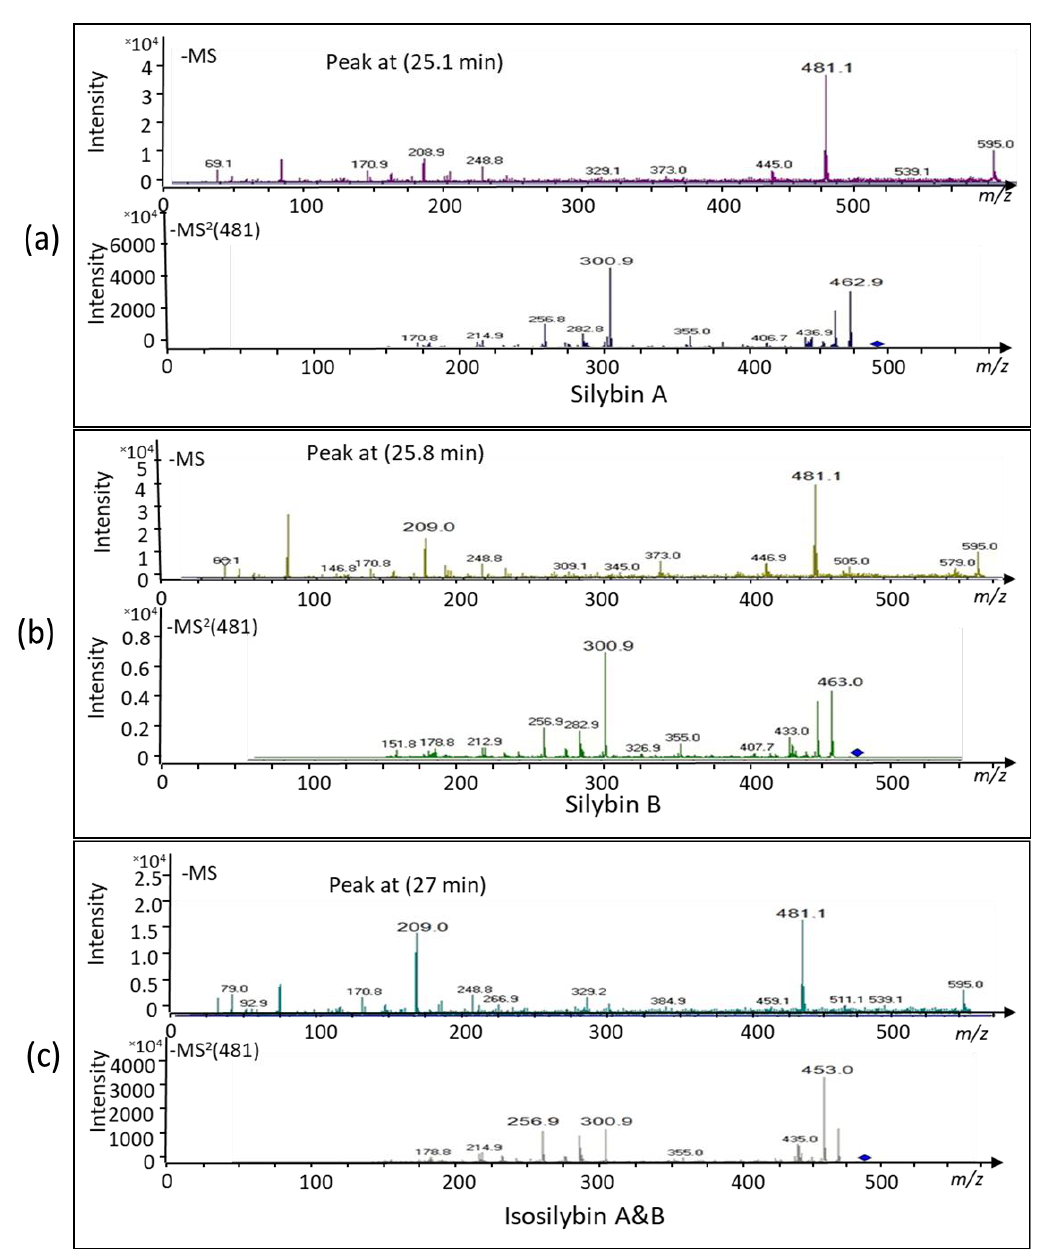
Figure 4. ESI-MS and MS/MS fragmentation pattern of the peaks eluted at 25.1, 25.8, and 27 min in the HPLC chromato- gram. ( a ) ESI-MS and MS/MS in the negative mode of the ion peak at 25.1 min. The obtained m/z values of 481.1 corresponded to the molecular mass of both silybin A and B. The assignment to silybin A followed the literature using the HPLC retention pattern where the first peak is A and the second B [7]. Also, the patterns obtained by MS 2 fragmentation of the m/z-peak at 481.1 were highly similar for both peak at 25.1 and 25.8 ( b ) confirming the correctness of assignment to silybin A and B. The MS 2 peak at 300.9 matched the main peak reported in [7], but also the peaks at 256.9 and 282.9, further confirming the presence of silybin A and B. ( c ) The obtained m/z values for the peak at 27 min matched the molecular mass of isosilybin A and B.